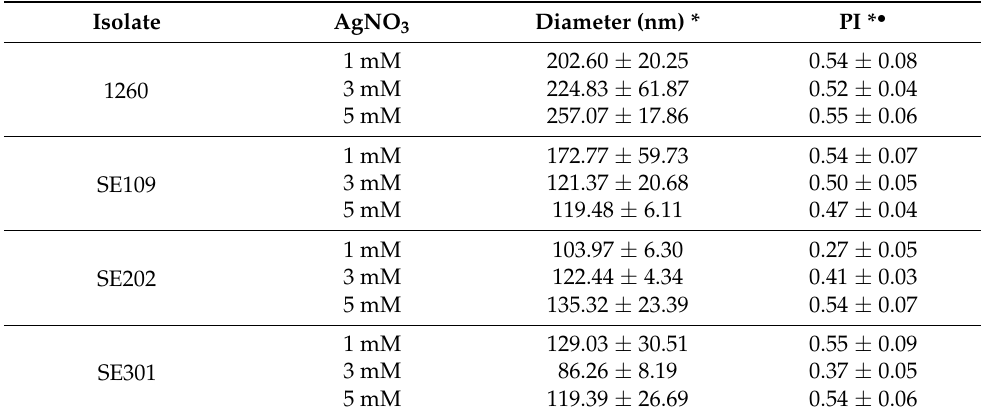
Table 2. Effect of silver nitrate (AgNO 3 ) concentration on the average diameter and polydispersity of silver nanoparticles synthesized with aqueous extracts of entomopathogenic